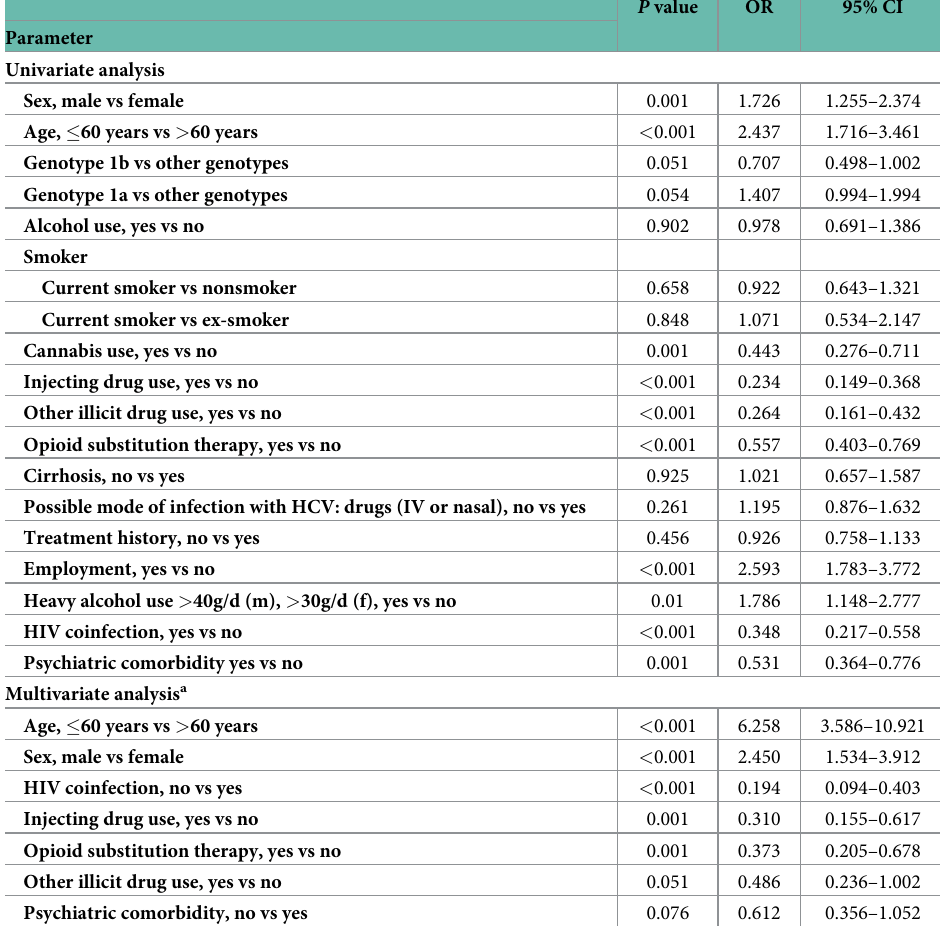
Table 4. Univariate and multivariate analyses of predictive factors for initiating CHC